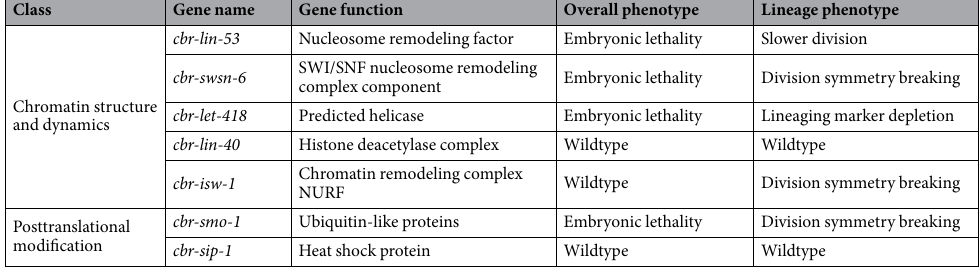
Table 1. Summary of RNAi phenotypes for the selected genes in lineage